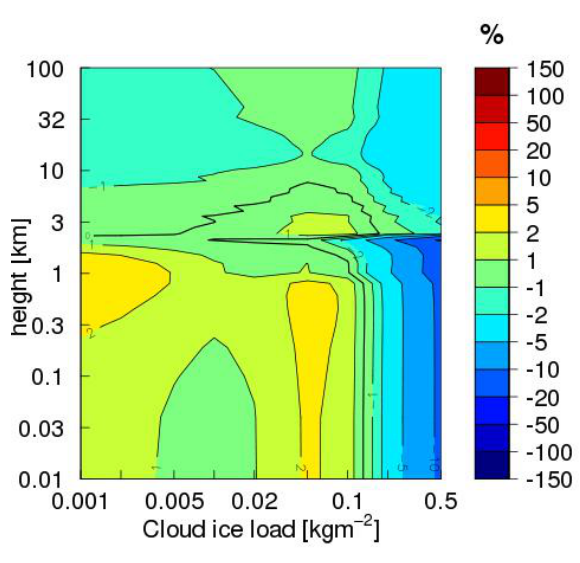
Figure 26. As for Fig. 2 but for the IFS radiation scheme using theFu and Liou (1993) ice cloud optical property parameterisation vs. Fu-DISORT (experiment 8)